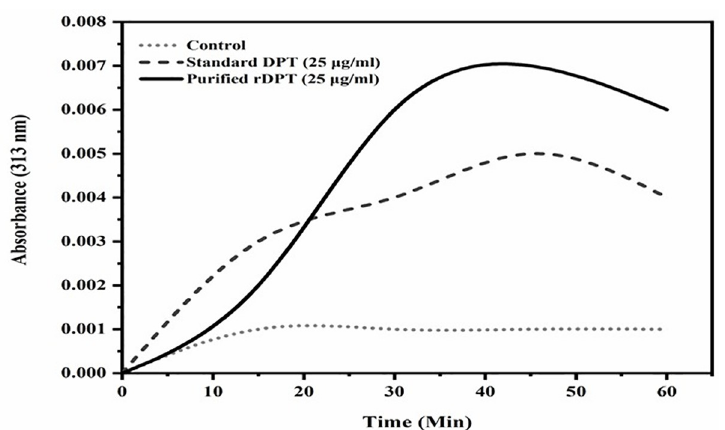
Fig 4. Collagen fibril assay. The graph represents the effect of Dermatopontin on collagen fibrillogenesis. Dermatopontin induces collagen fibril formation and the rate of fibril formation was significantly enhanced in DPT treated wells compared to control. Collagen I was mixed at a constant concentration of 500 μ g/ml with equal concentrations (25 μ g/ml) of purified recombinant Dermatopontin and standard. Equal volume of fibril formation buffer was added to all wells. Fibrillogenesis was monitored by optical density-based turbidity measurement at 313 nm.